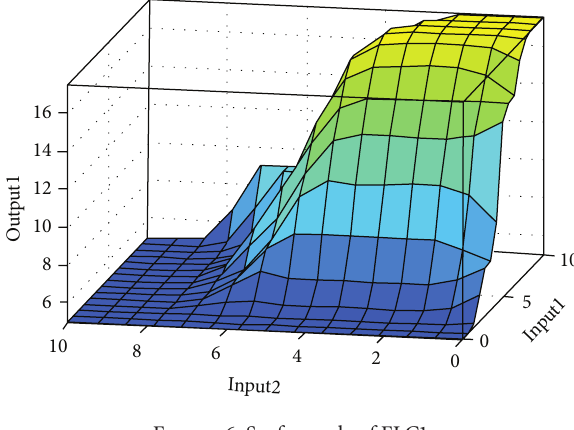
Figure 6: Surface rule of FLC1.